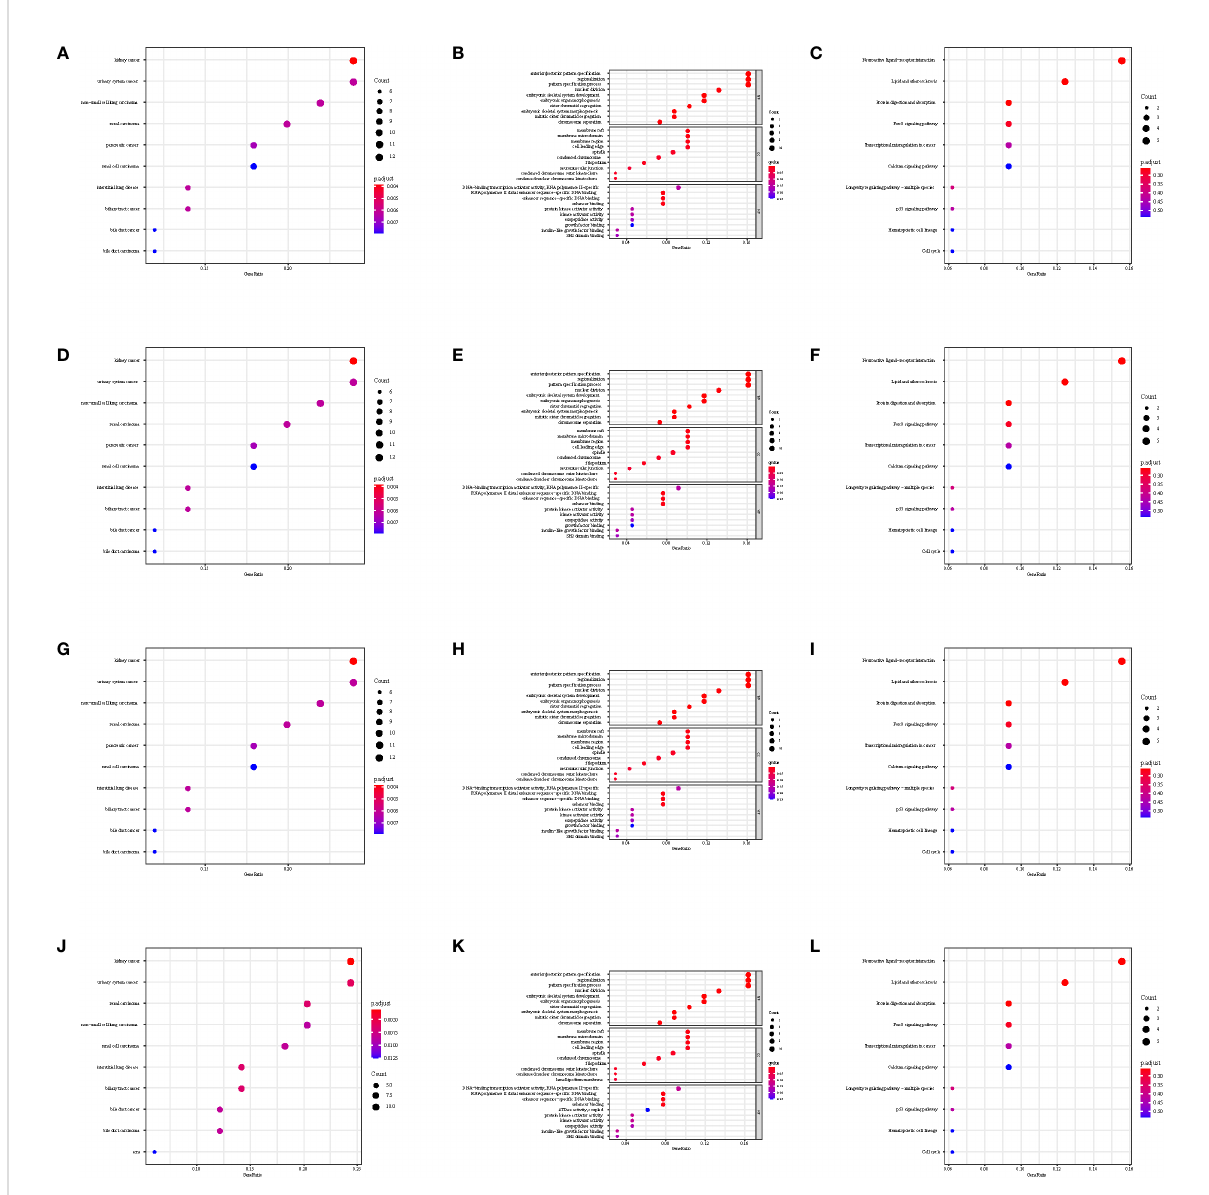
FIGURE 6 Disease Ontology, Gene Ontology, and Kyoto Encyclopedia of Genes and Genomes functional analysis in GSE7890. (A – C) DKK1, (D – F) JAG1, (G – I) LGR5, and (J – L)